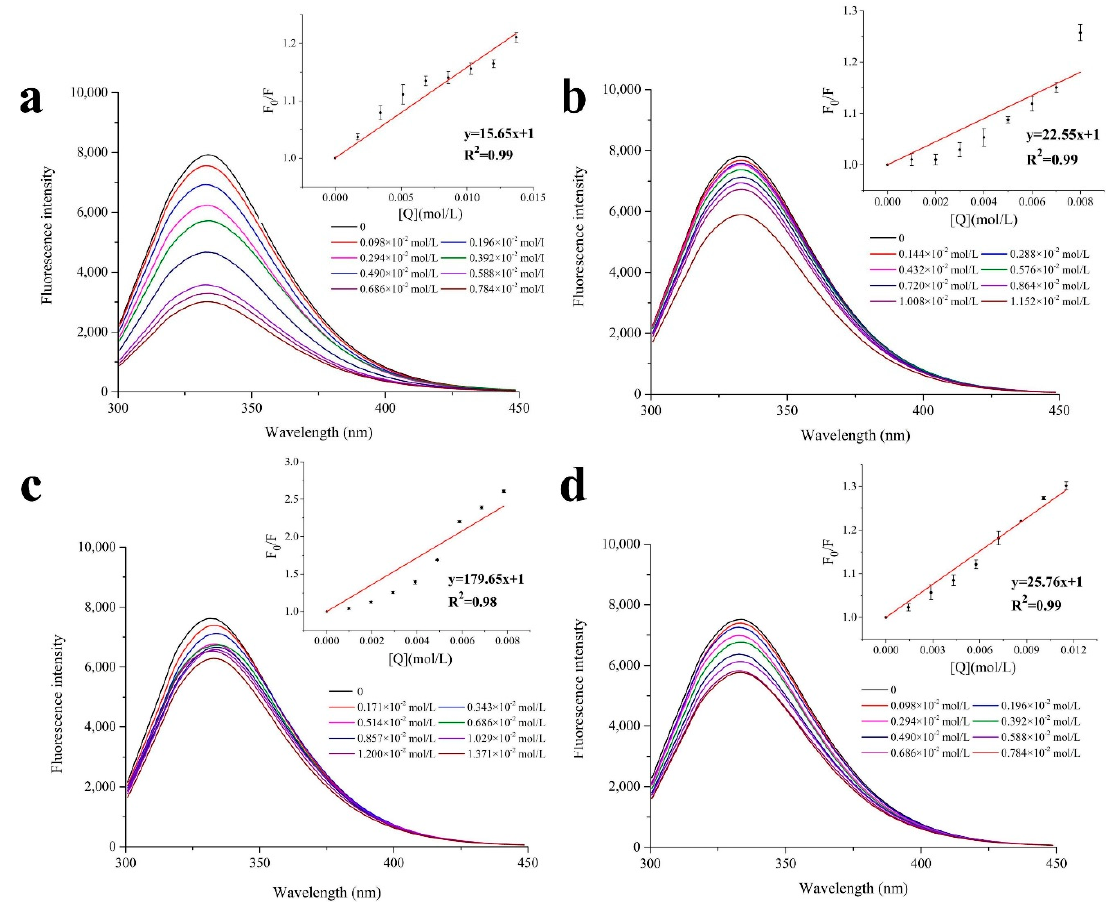
Figure 2. Fluorescence spectra analysis of the interaction between MP and butyraldehyde ( a ), 2 ‐ pentanone ( b ), octanal ( c ), and 2 ‐ octanone ( d ).